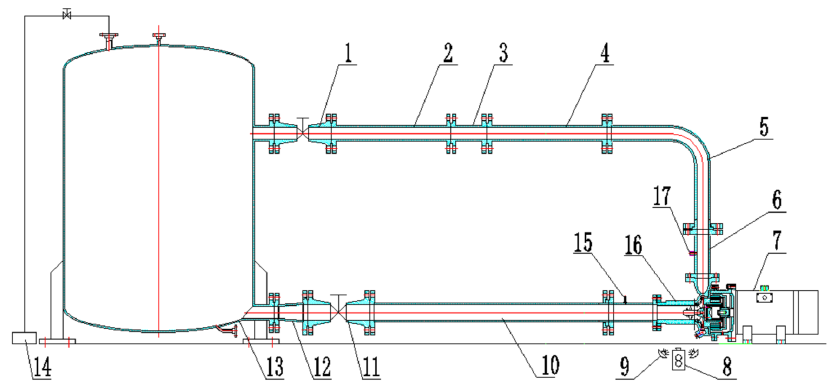
Figure 3. Schematic diagram of the test rig.